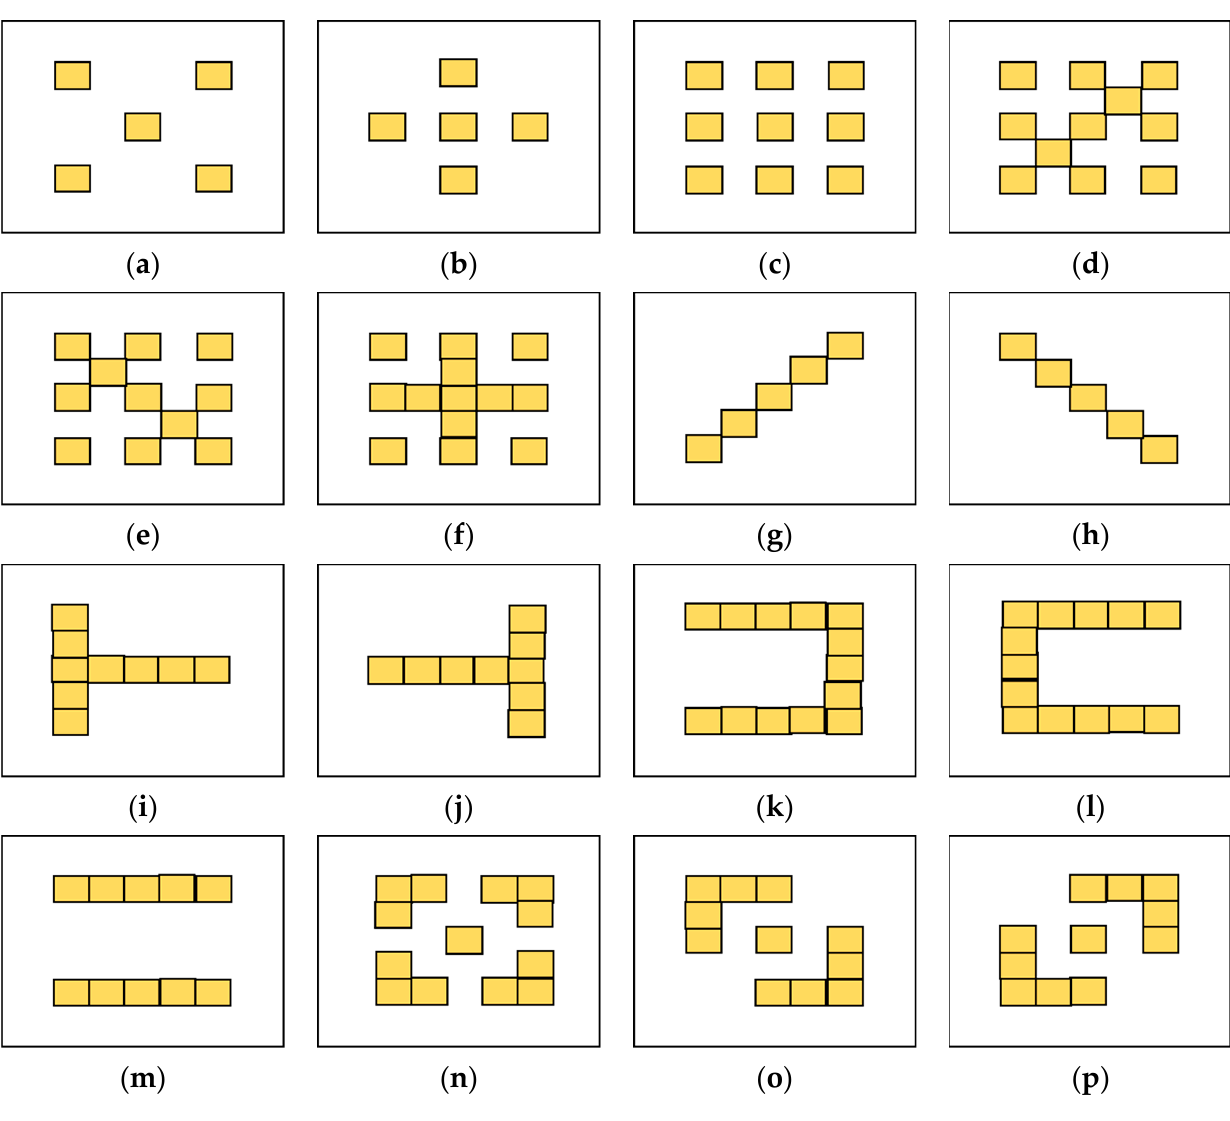
Figure 19. Sixteen scene layouts: ( a ) scene layout #1; ( b ) scene layout #2; ( c ) scene layout #3; ( d ) scene layout #4; ( e ) scene layout #5; ( f ) scene layout #6; ( g ) scene layout #7; ( h ) scene layout #8; ( i ) scene layout #9; ( j ) scene layout #10; ( k ) scene layout #11; ( l ) scene layout #12; ( m ) scene layout #13; ( n ) scene layout #14; ( o ) scene layout #15; ( p ) scene layout #16.